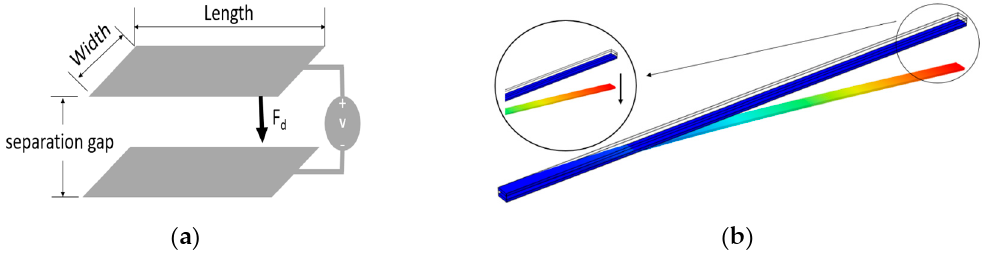
Figure 1. Schematic view of ( a ) a parallel plate electrostatic actuator and ( b ) an arm with one fixed bottom electrode showing the downward movement of the arm. The arm’s width, length, and voltage are 8 µm, 400 µm, and 50 V, respectively, whereas the width and length of the bottom electrode are 10 µm and 400 µm, respectively.